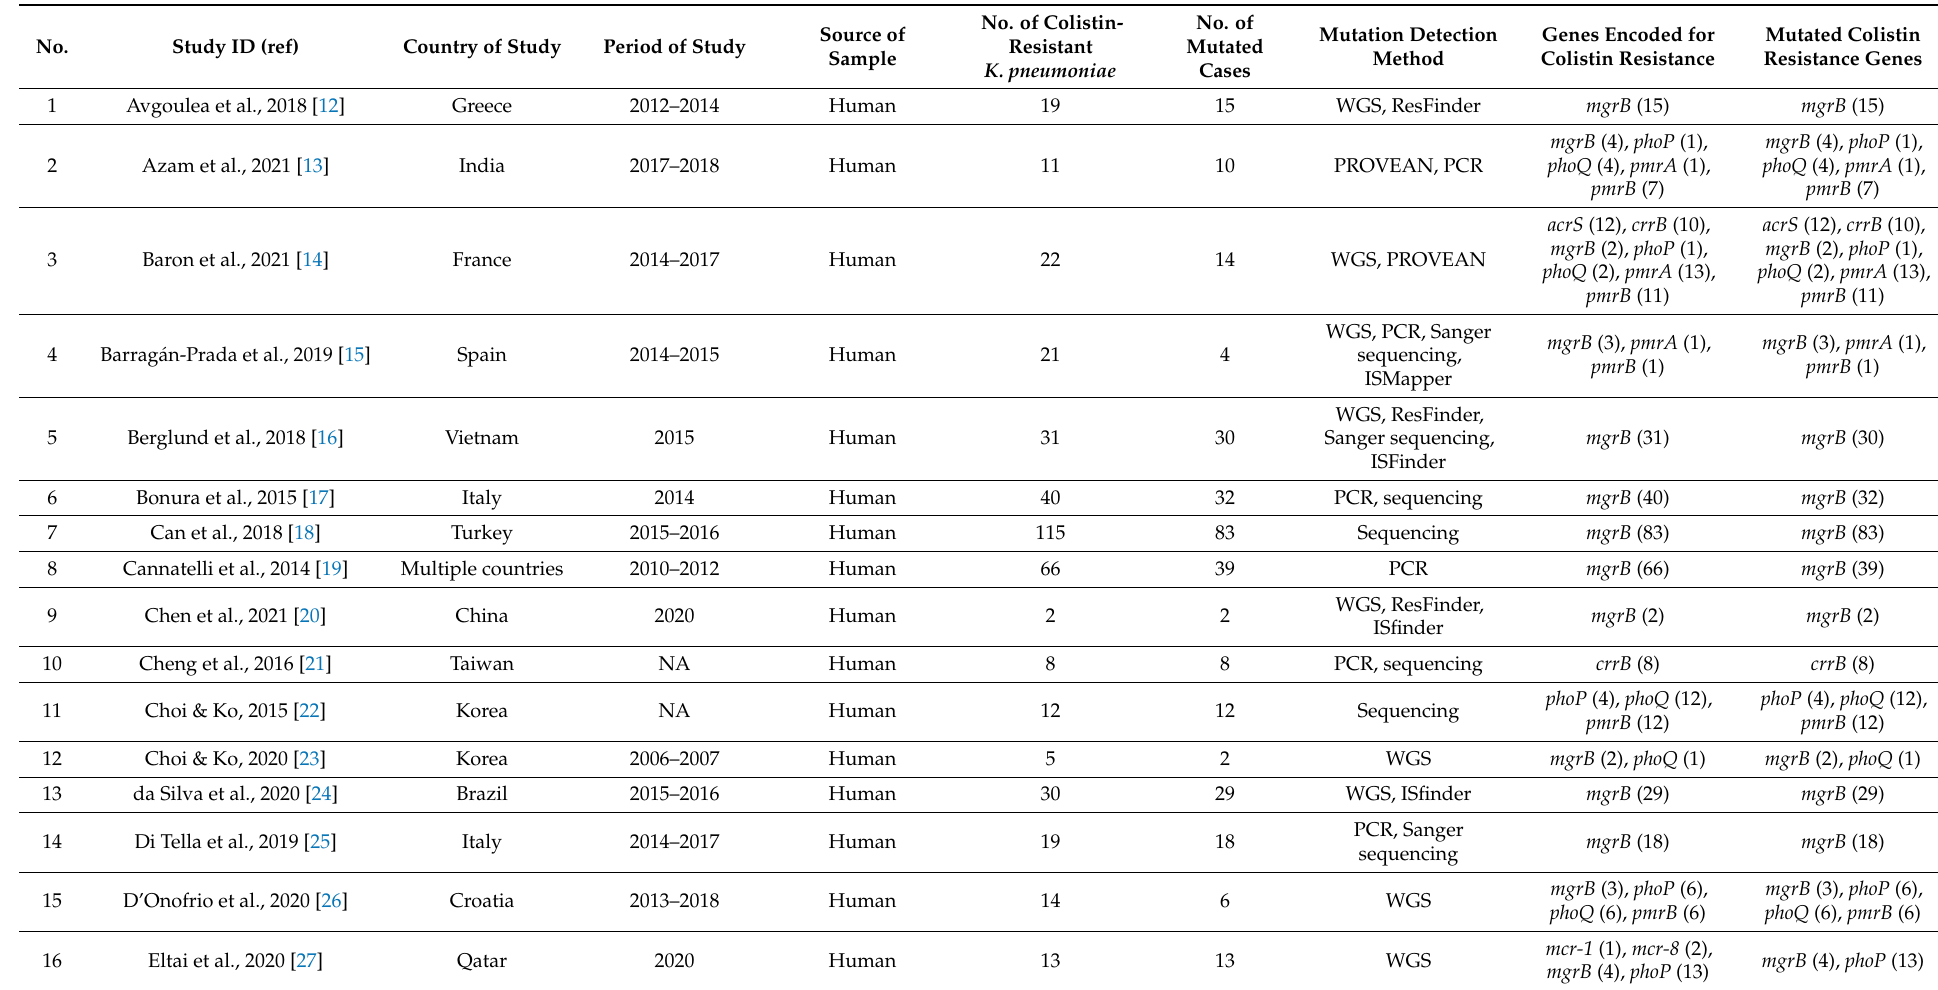
Table 1. Characteristics of the 50 included studies in this